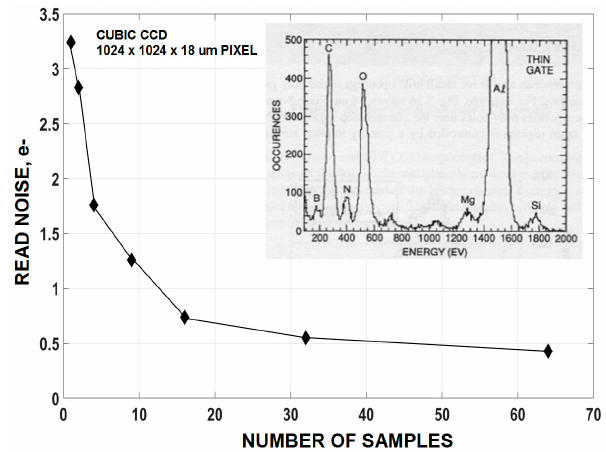
Figure 16. Nondestructive readout of the CUBIC imager showing how the read noise decreases with the number of samples averaged [1]. Embedded in the figure is a low energy soft X-ray histogram showing B, C, N and O lines with Fano-noise limited performance.